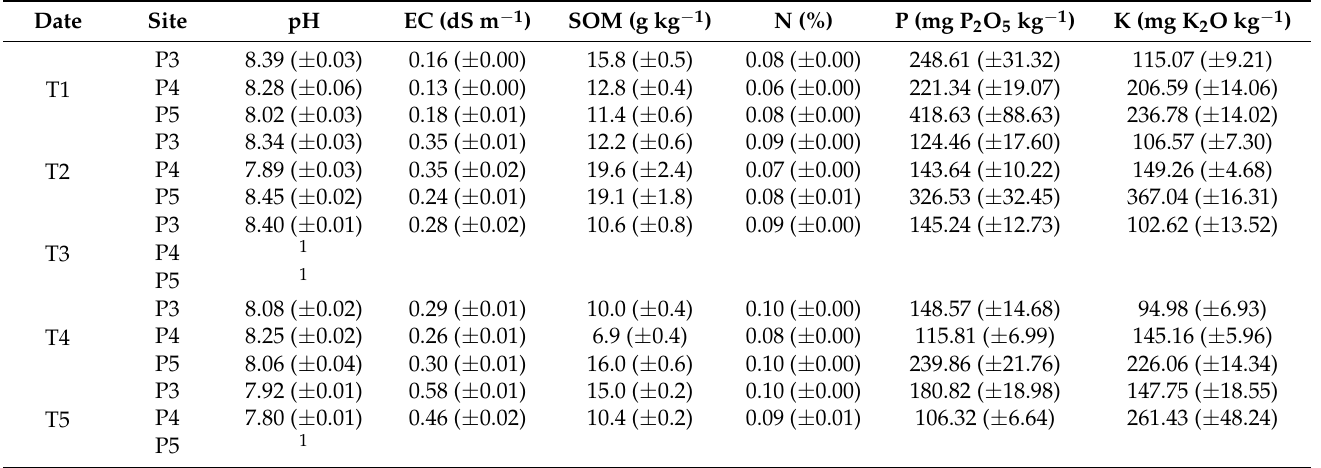
Table 4. Average values ( ± standard error) of soil chemical parameters in each site (P3 ( n = 9), P4 ( n = 9), P5 ( n = 12)), in the 0–20 cm layer, during the study (T1, T2, T3, T4, and T5 sampling dates).